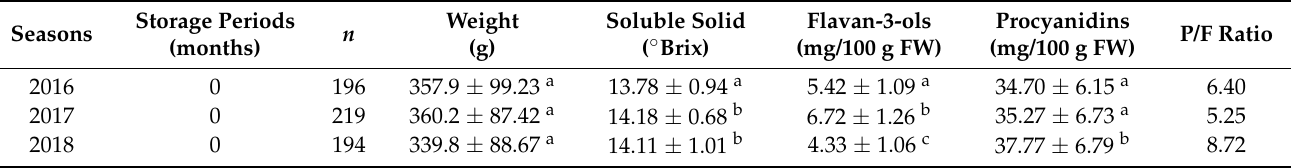
Values are means ± standard deviation. P/F refers to the procyanidins to flavan-3-ols ratio. Flavan-3-ols and procyanidins were equated to (–)-epicatechin and procyanidin B2, respectively. The mean values within a verse with different letters are significantly different at p < 0.05 according to Tukey’s multiple comparisons test.